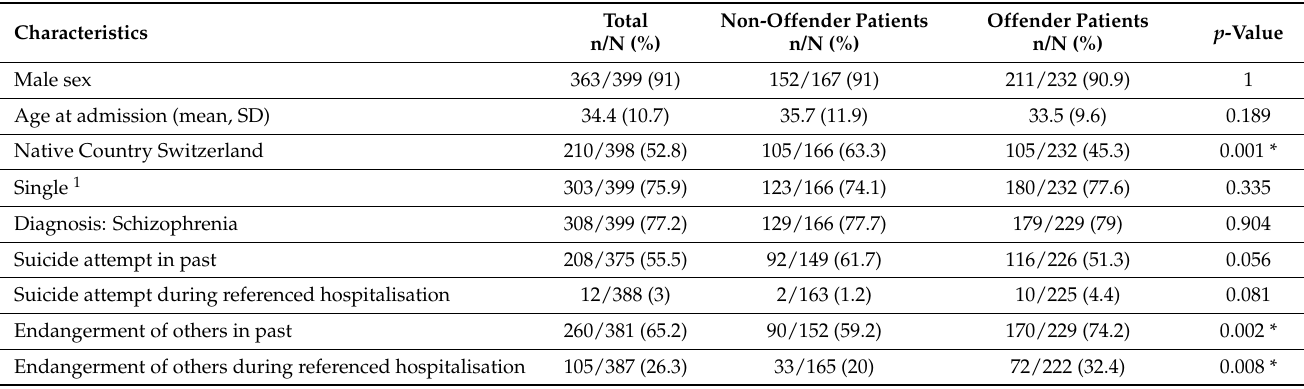
Table 1. Demographic characteristics of the study